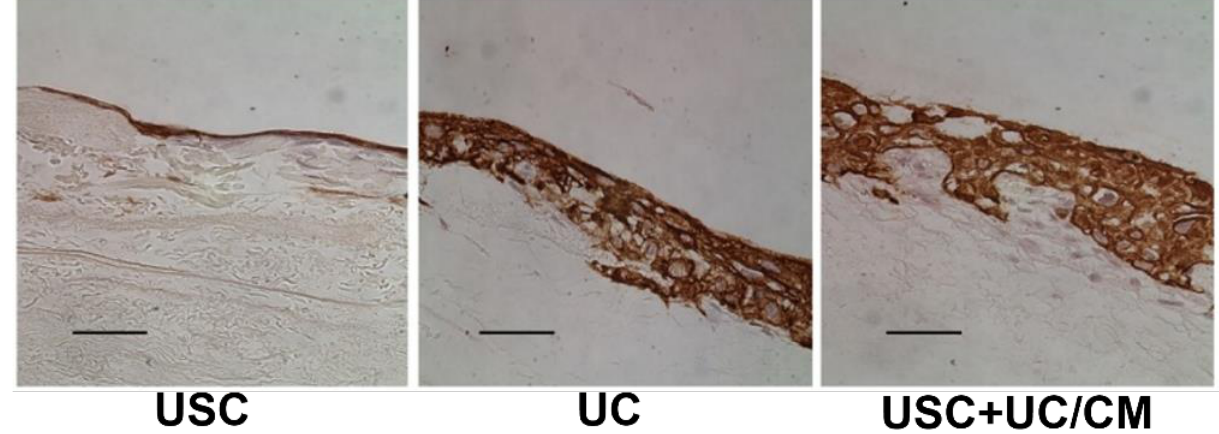
Figure 4. Multiple-layered structure of the USC cell sheet on SIS. Treated with UC/CM, USC formed a cell sheet with five to seven layers resembling natural urothelium, while USC alone generated a thin layer of urothelium. Scale bar = 50 µ m. Abbreviations: USC, urine-derived stem cells; UC/CM, urothelium conditioned medium; SIS, small intestinal submucosa. The images are adapted from Stem Cell Res Ther. [56] with permission. (License link: http://creativecommons.org/licenses/by/4.0/ accessed on 13 April 2022).